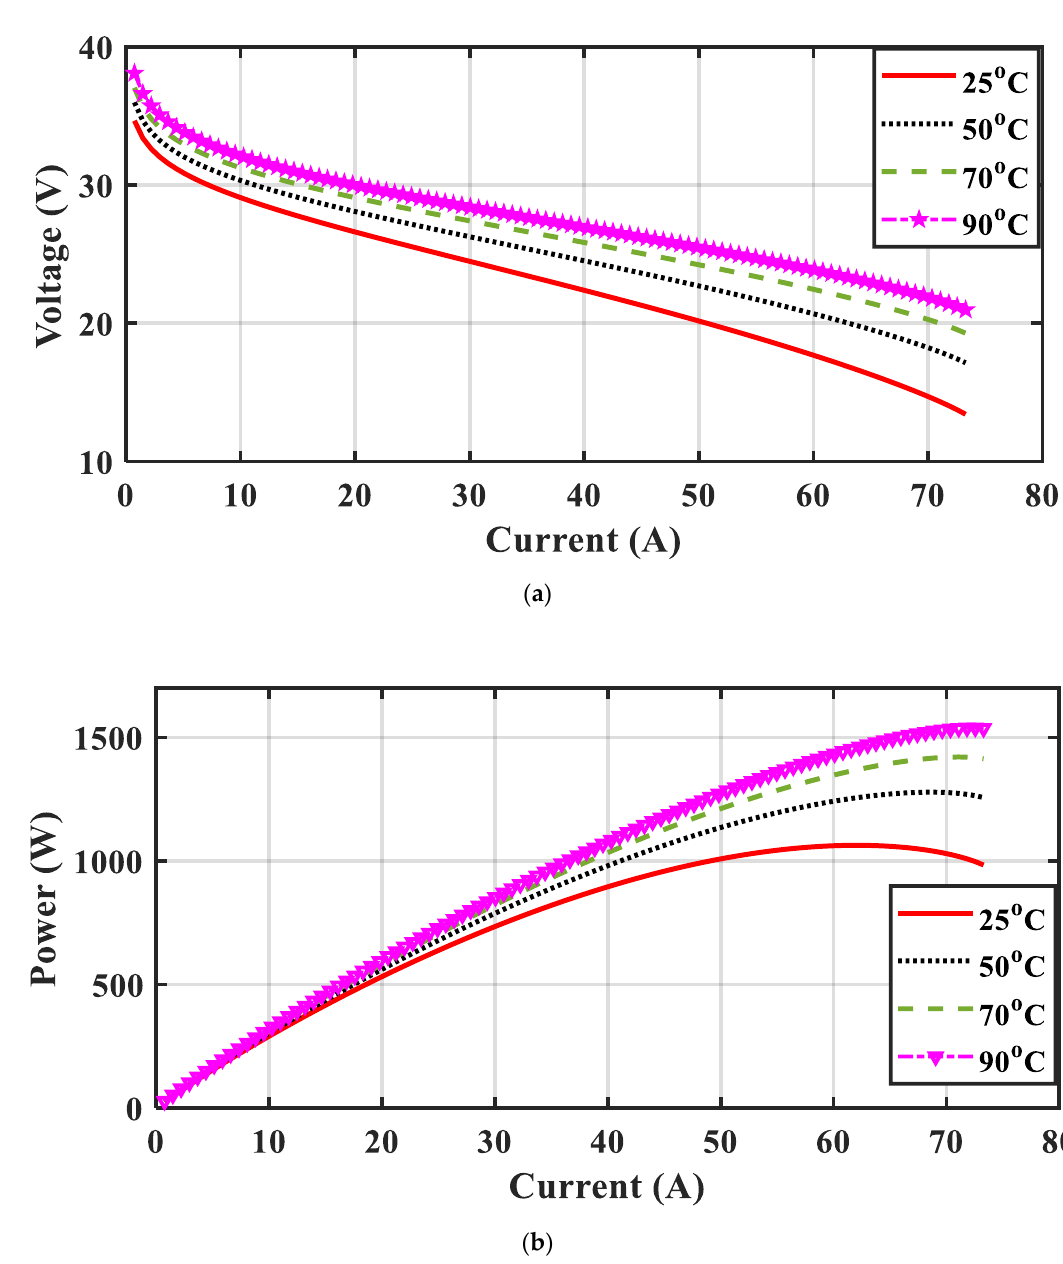
Figure 4. Polarization curves of Ballard fuel cell using the HGS algorithm under various temperature conditions at constant pressure. ( a ) I–V curves. ( b ) I–P curves.